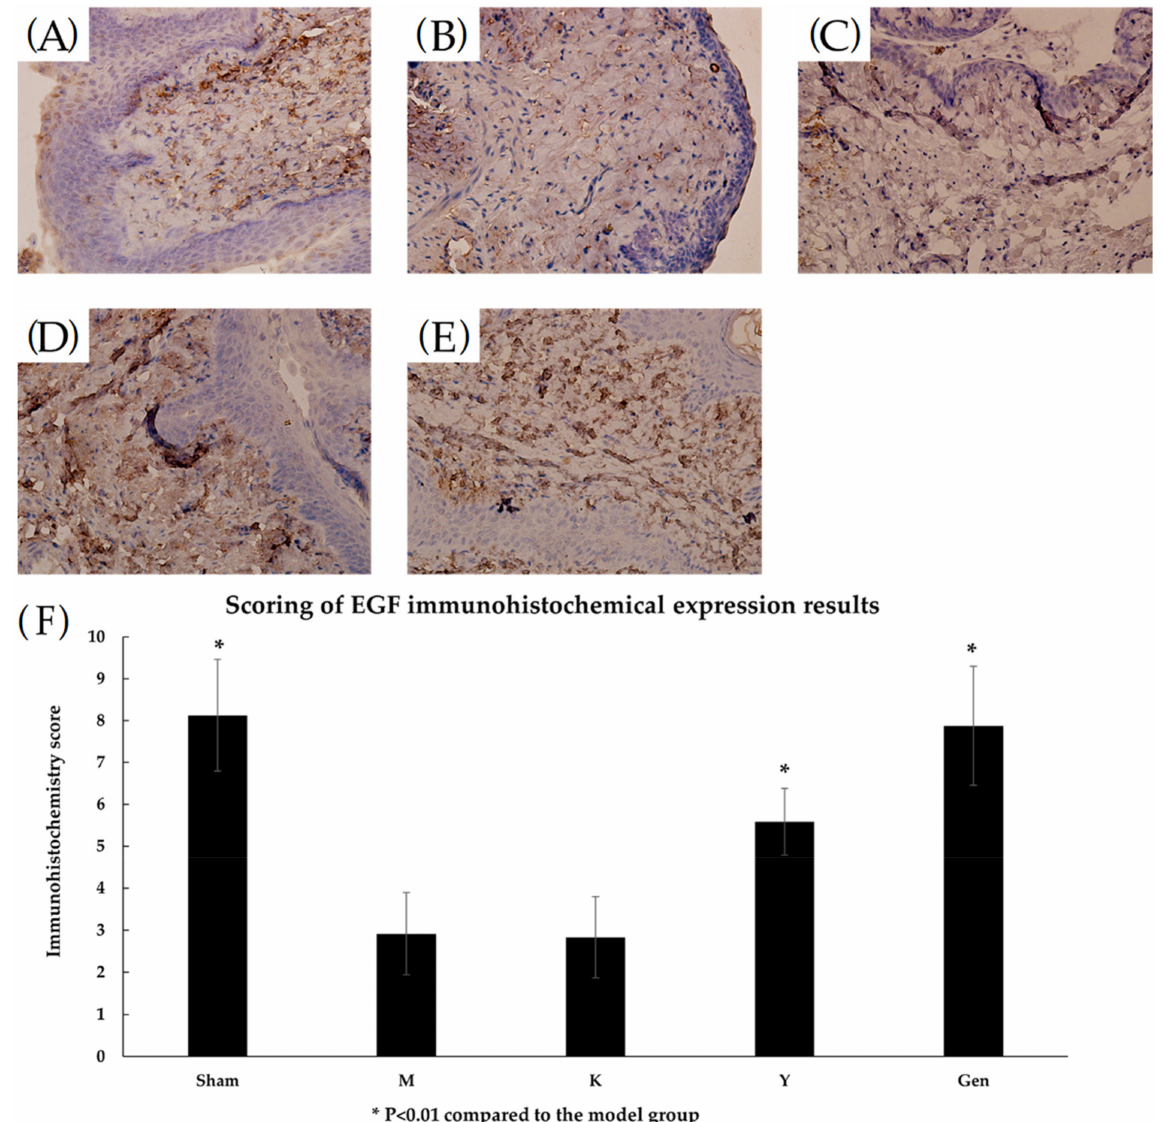
Figure 9. ( A ) High expression of EGF protein in the vaginal tissues of Sham rats, (40X). ( B ) Low expression of EGF protein in vaginal tissues of group M rats, (40X). ( C ) Low expression of EGF protein in vaginal tissues of group K rats, (40X). ( D ) Immunohistochemical results of vaginal tissues of rats in group Y with moderate positive expression of EGF protein, (40X). ( E ) Immunohistochemical results of vaginal tissues from the Gen group of rats were strongly positive for EGF protein with high expression, (40X). ( F ) EGF immunohistochemistry score results for each group. * p < 0.01 compared to the model